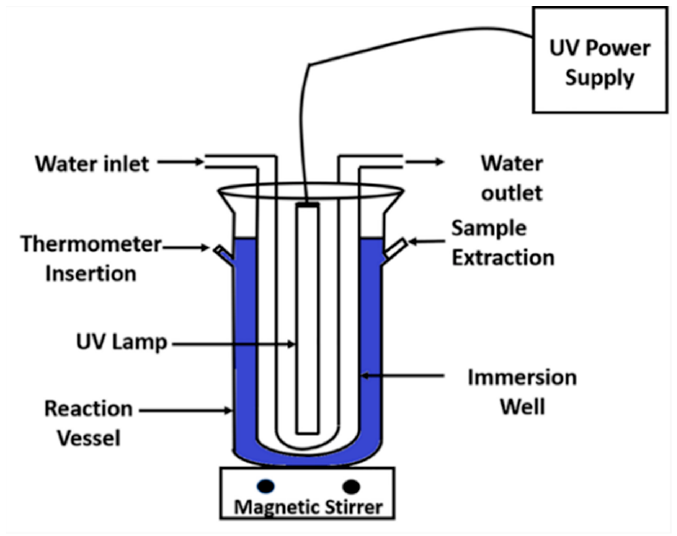
Figure 12. Schematic diagram of the experimental set-up used for photocatalysis tests. Reproduced with permission from Ref. [32]; published by Springer Nature, 2018.